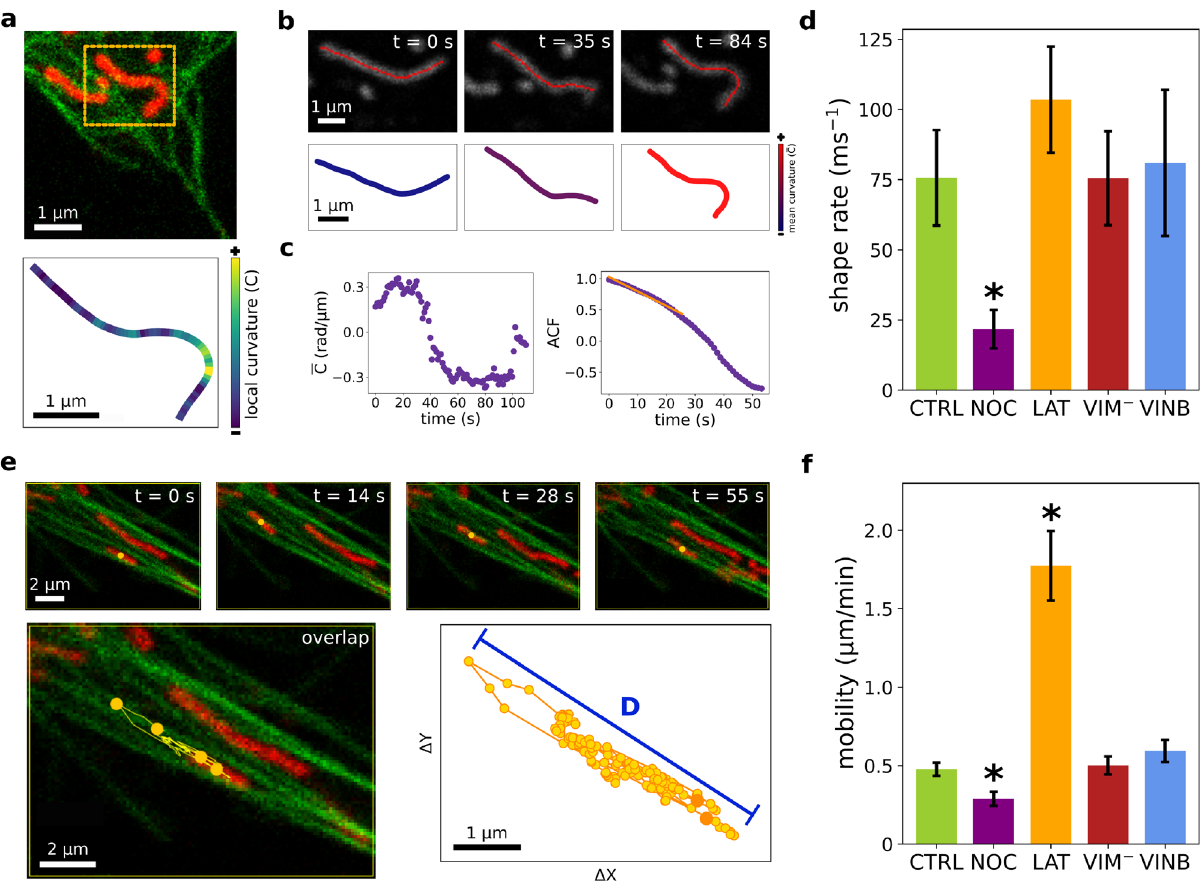
Figure 3. Mitochondria shape fluctuations and mobility. ( a – c ) Quantification of mitochondria curvature variation. Example of a mitochondrion shape and local curvature ( C ) along its length (a). The mean curvatures ( C ) determined at each frame of the time-stacks ( b ) were used to calculate the ACF ( c ) as described in “Methods”. ACF data was fitted with an exponential decay function to obtain the characteristic time. ( d ) Mitochondria curvature fluctuation rate. The characteristic decaying time obtained from ACF analysis was used to compute the organelles shape fluctuation rate for each experimental condition. ( e ) Mitochondria mobility analysis. Representative time-lapse images of a moving mitochondrion (top panel). The spatial coordinates of the organelles (red) were recovered in each frame of the movies to obtain the trajectory of its center of mass (orange circles), (bottom panel). The start and end point of the trajectory are shown in dark orange. The maximum displacement of the organelle (D) is schematized as a blue segment. ( f ) Quantification of mitochondria mobility. Asterisks denote significant differences (p-value < 0.05) with respect to the control condition. Supplementary Table S6 displays the values shown in ( d , f